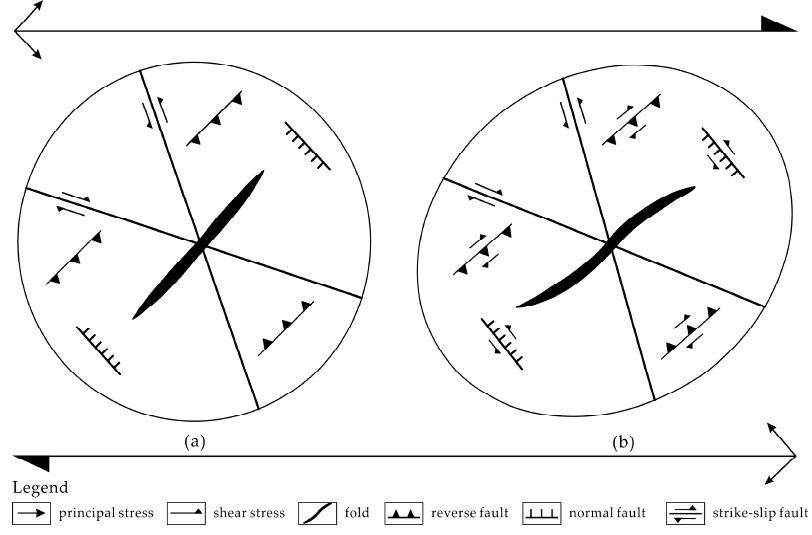
Figure 18. Stress regime during the formative process of the folds with sigmoidal axes, modified from [42].